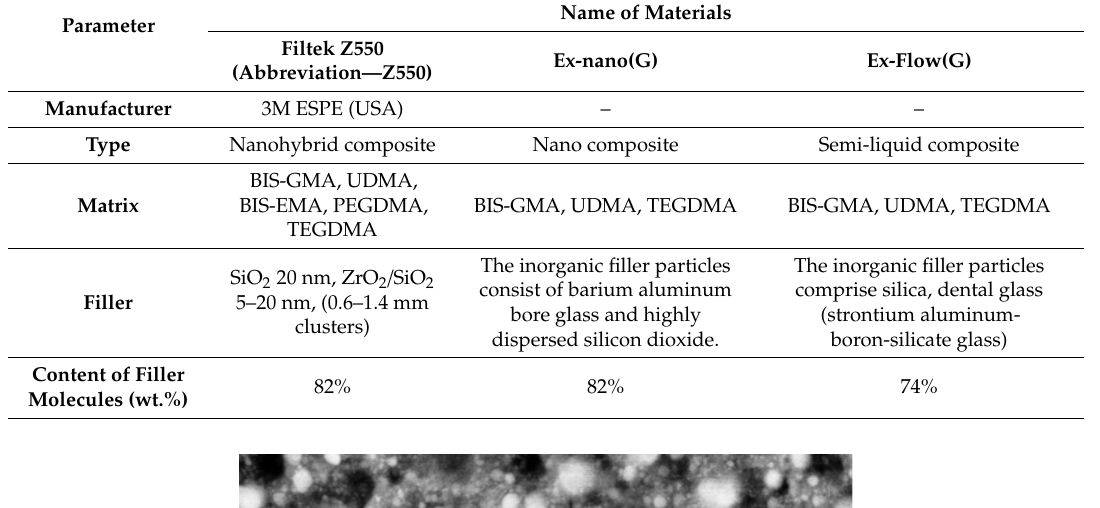
Table 1. Details about tested composites.